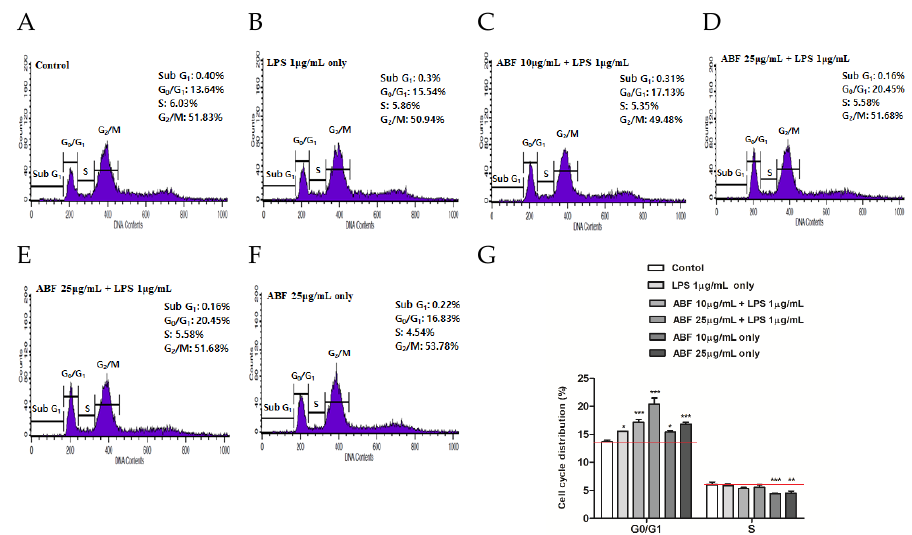
Figure 6. Induction of cell cycle arrest by aronia bioactive fraction (ABF ® ). Cells were pretreated with ABF ® (10 and 25 μg/mL) for 6 h and then treated with lipopolysaccharide (LPS) (1 μg/mL) for 24 h. Cell cycles of the control and ABF ® -pretreated cells were analyzed by flow cytometry. (G) Changes in the G0/G1 and G2/M phases of ABF ® -pretreated cells were compared with those of control cells. The values are presented as means ± standard deviation (SD) of three independent experiments. * p < 0.1, ** p < 0.05, *** p < 0.01 indicate significant differences as compared to the control cells. ( A ), Control; ( B ) , LPS 1 μg/mL only; ( C ) , ABF 10 μg/mL + LPS 1 μg/mL; ( D ) , ABF 25 μg/mL + LPS 1 μg/mL; ( E ), ABF 10 μg/mL only; ( F ) , ABF 10 μg/mL only. Antioxidants 2020 , 9 , x FOR PEER REVIEW